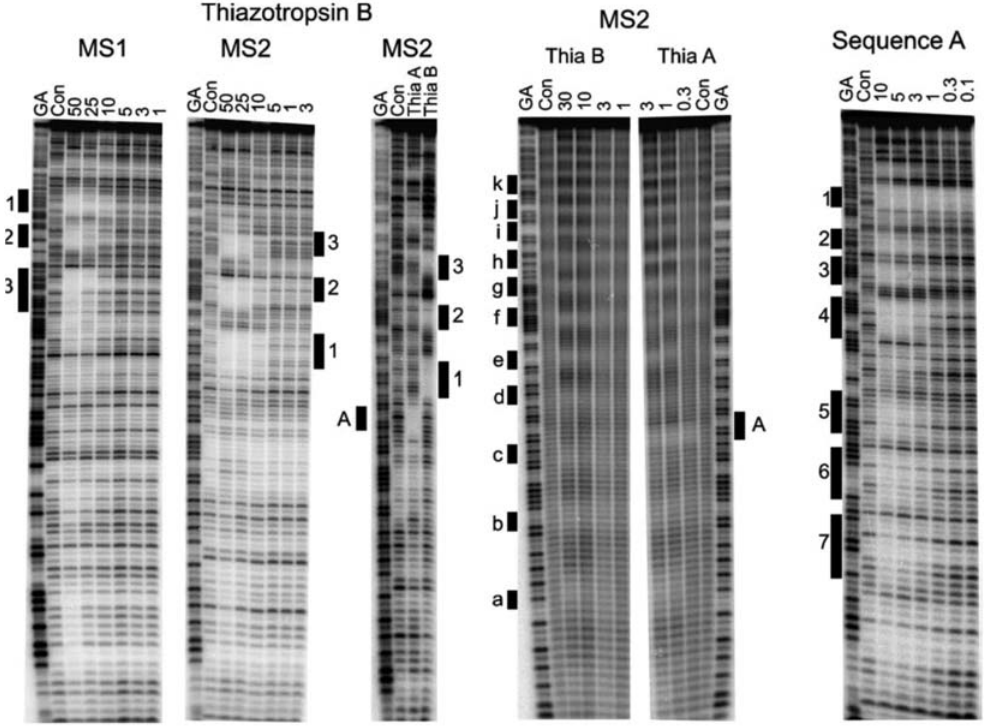
Figure 4. The first two panels show deoxyribonuclease I footprints for Thiazotropsin B on MS1 (top strand, Figure 4a) and MS2 (bottom strand, Figure 4a). The third panel compares the deoxyribonuclease I footprints for Thiazotropsin A (10 μM) and Thiazotropsin B (50 μM) on MS2. šA’in- dicates the location of the binding site for Thiazotropsin A. The fourth and fifth panels show hydroxyl radical cleavage patterns for these ligands on the MS2 fragment. The final panel shows deoxyribonuclease I cleavage patterns of Sequence A in the presence of Thiazotropsin B. Ligand concen- trations (μM) are shown at the top of each gel lane. GA corresponds to marker lanes specific for purines, while šCon’is cleavage in the absence of added ligand. The filled boxes show the location of the best binding sites (reproduced from the reference 15 with permission from Bioorg. Med. Chem. Lett. , license number: